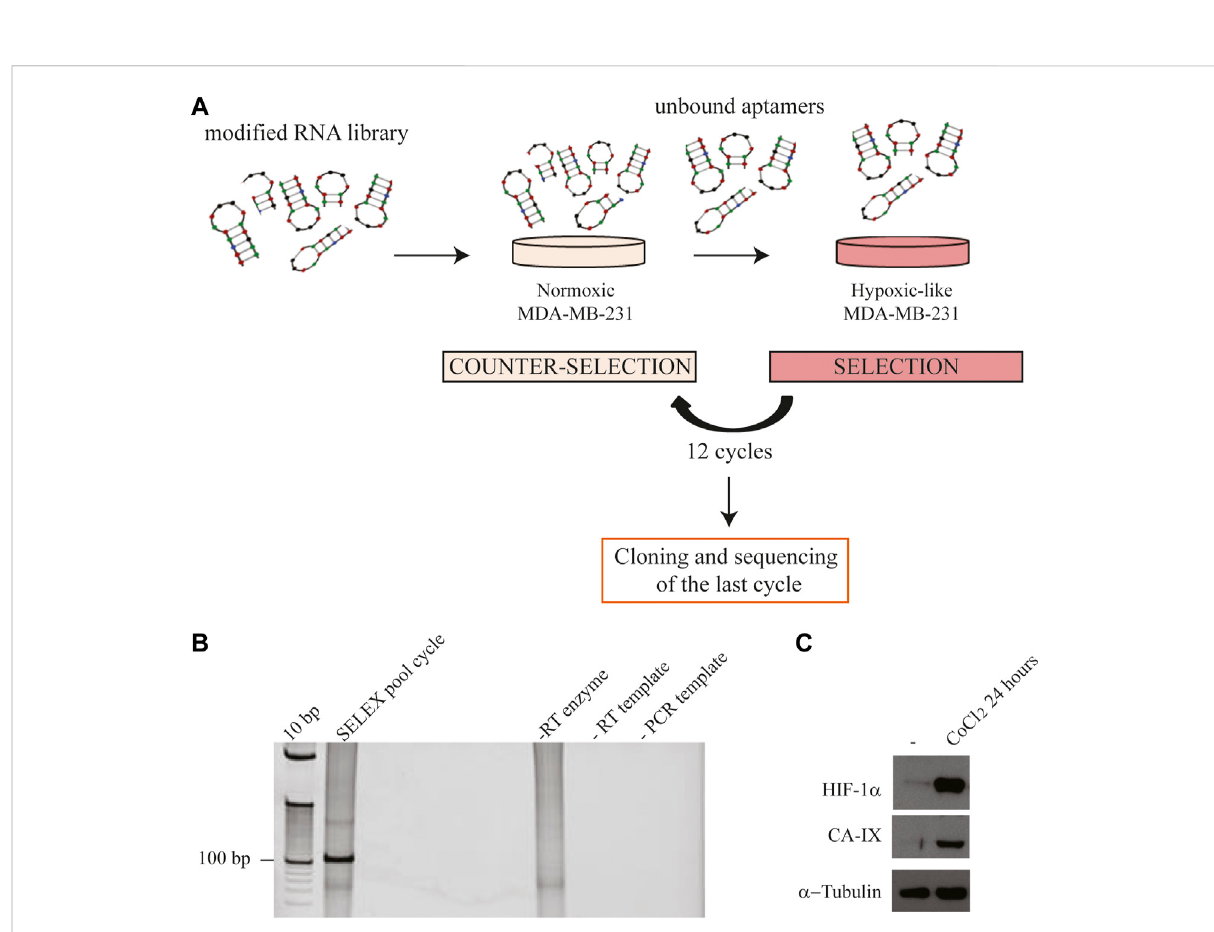
Hypoxic cell-SELEX strategy. (A) Each SELEX round included one or two “ counter-selection steps ” on normoxic MDA-MB-231 and one “ selection step ” on CoCl (B) Representative RT-PCR ampli fi cation of the aptamer pool was obtained 2 -induced MDA-MB-231 cells (hypoxic-like). followingaSELEXround.Sampleswereloadedontoa12%polyacrylamidegel,stainedwithethidiumbromideandvisualisedbyUVexposure.Control samples: “ -RT enzyme ” indicates the pool reverse-transcribed without the reverse-transcriptase enzyme, performed to exclude DNA contaminationinRT; “ -RTtemplate ” indicatestheampli fi cationoftheproductfromanRTreactionperformedwithouttheRNAtemplate,toexclude RNAcontaminationinRT; “ -PCRtemplate ” indicatesthenegativecontrolofthePCRreaction; (C) RepresentativeimmunoblotanalysisofHIF-1 α and CA-IXexpressiononnormoxic(usedinthe “ counter-selectionstep ” )andCoCl 2 -inducedhypoxicMDA-MB-231cells(usedinthe “ selectionstep ” ). α - Tubulin was used as a housekeeping